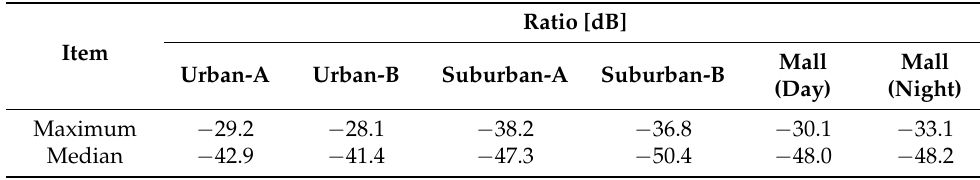
Table 2. Ratio of E-field strength to values in the Japanese guidelines.